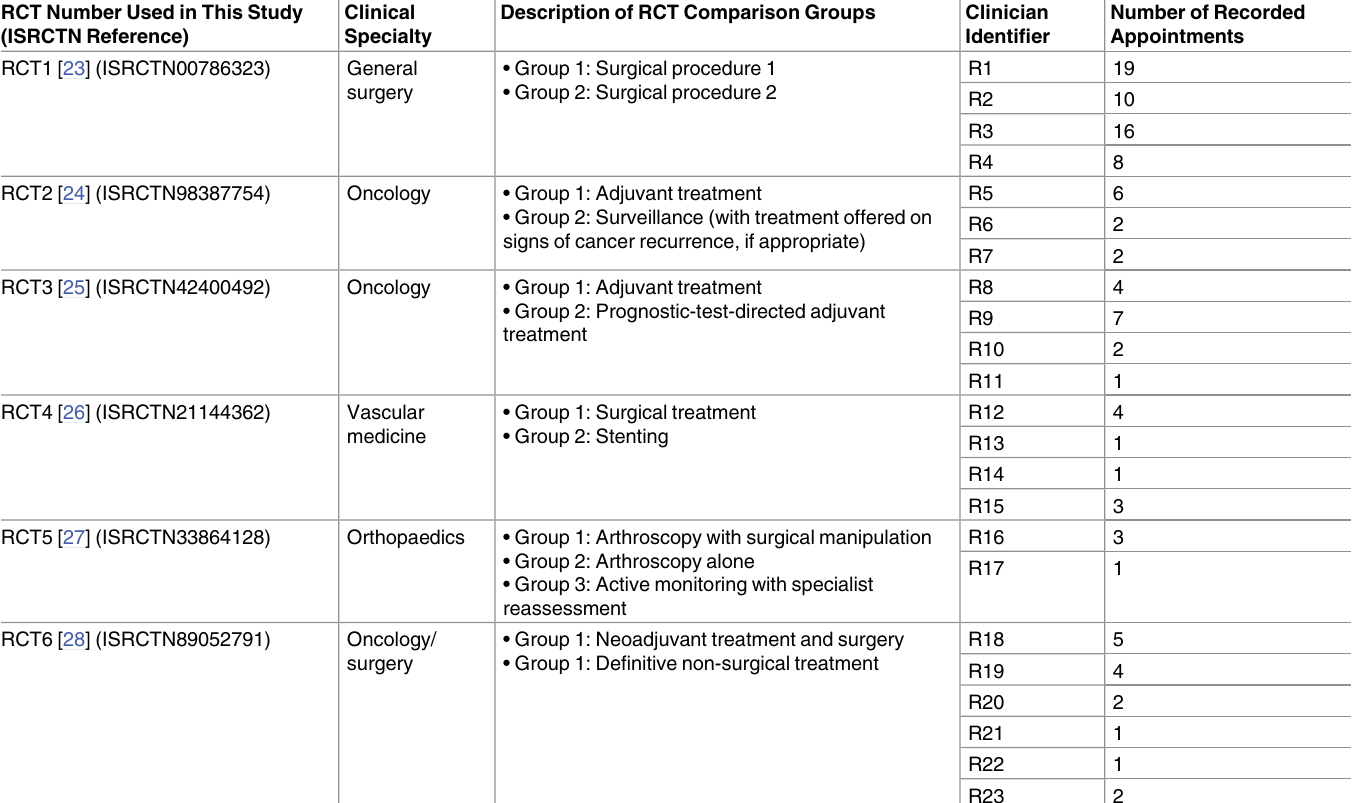
Table 1. RCT details and associated number of appointments recorded (shown by participating clinician). RCT Number Used in This Study (ISRCTN